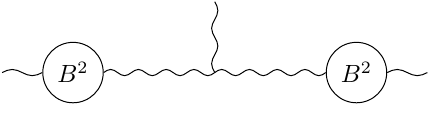
Figure 6 . The Feynman diagram capturing the tr( B 2 ) tr( B 2 )